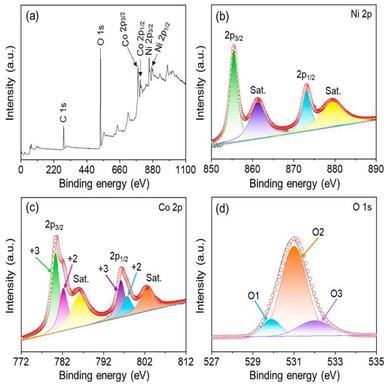
(a) The full-scanned XPS spectrum of CoNi LDH NFs and the high-resolution spectra of (b) Ni 2p, (c) Co 2p, and (d) O1s, respectively.